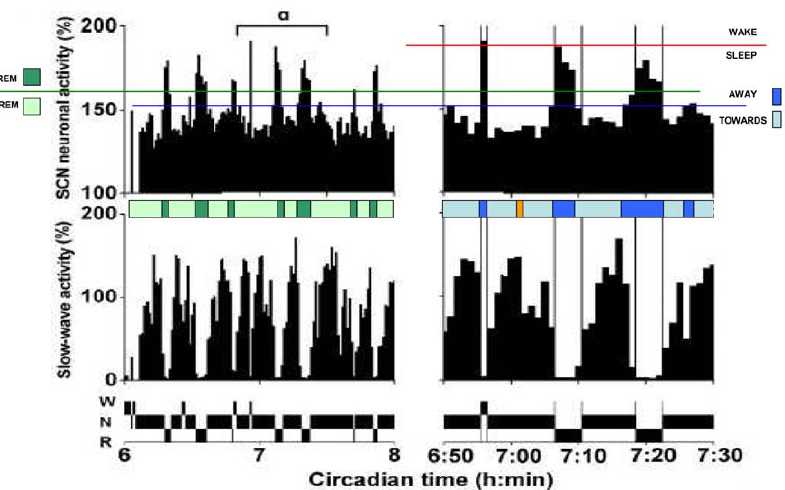
Figure 5. Vigilance states, slow-wave activity and SCN neuronal activity. The left hand panels show an expansion of the data in Figure 4 (labelled c), representing 2 hours around the circadian peak. Right hand panels are an expansion of a portion of the recordings in the left hand panels (labelled a). Vertical lines on the right hand panels indicate vigilance state transitions, adapted from Deboer et al. [35] with the kind permission of the publisher. We have added a horizontal blue line on the SCN activity figure, above which SWA is falling rapidly to zero and below which SWA is rising slowly. These zones correspond to the ‘ Away ’ and ‘ Towards ’ phases of the NTP model. The blue colour-coded bar above the SWA figure shows the start and stop times of each phase. The orange rectangle on this bar indicates the position of an away phase of the SWA where the SCN data do not cross the threshold line as would be expected. The green colour-coded bar added above the SWA figure on the left hand panel, based on the green line threshold at about 160% on the SCN activity panel, show the SCN potential to control NREM-REM state transitions.